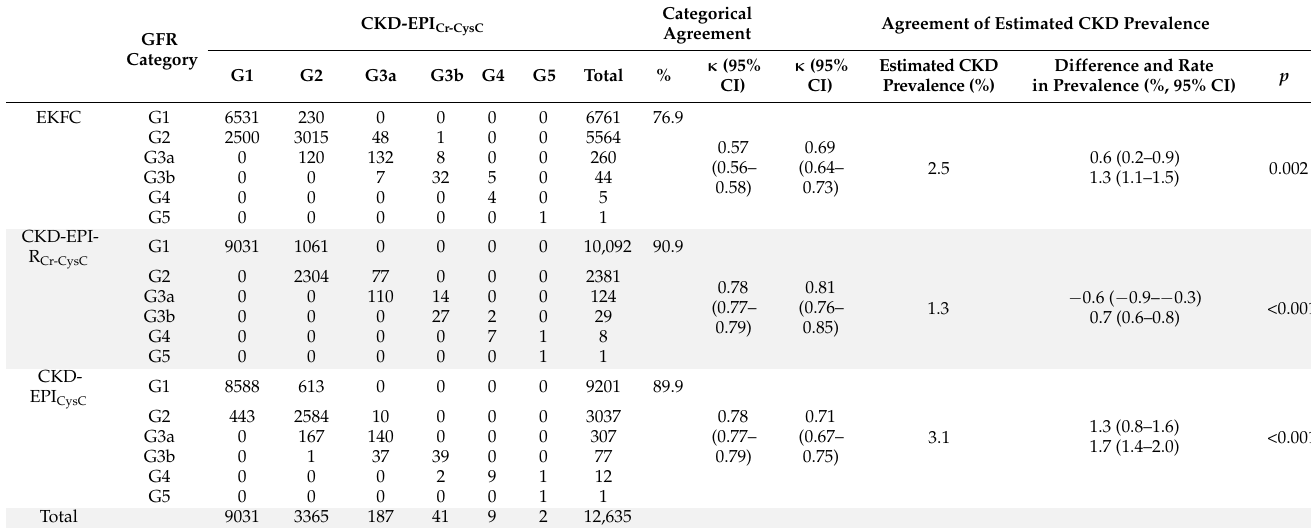
All p values were <0.001. Equations and correlation coefficients (r) were obtained using Passing–Bablok regression, and mean differences were obtained using Bland–Altman plots. Abbreviations: see Table 1; Cr, creatinine; CysC, cystatin C. Table 5. Agreement of GFR categories among serum creatinine- and cystatin C-based CKD-EPI, EKFC, and CKD-EPI-R